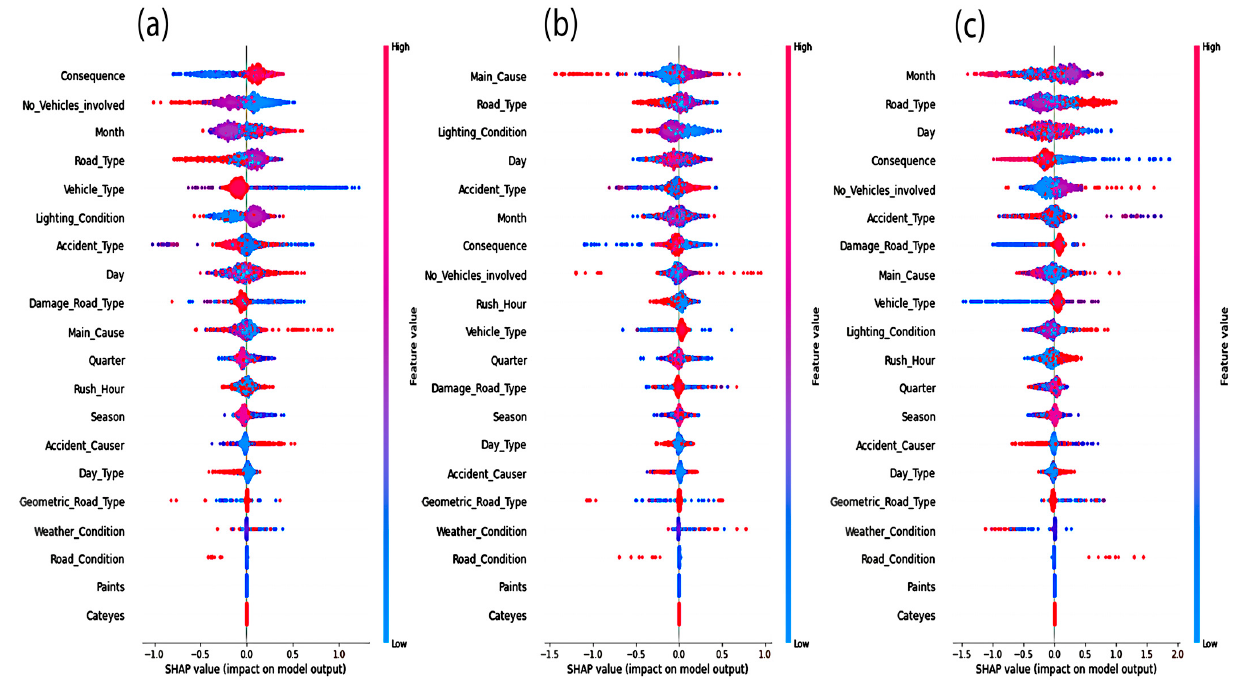
Figure 7. SHAP plots for variable importance per class: ( a ) PDO class; ( b ) injury class; ( c ) death class.